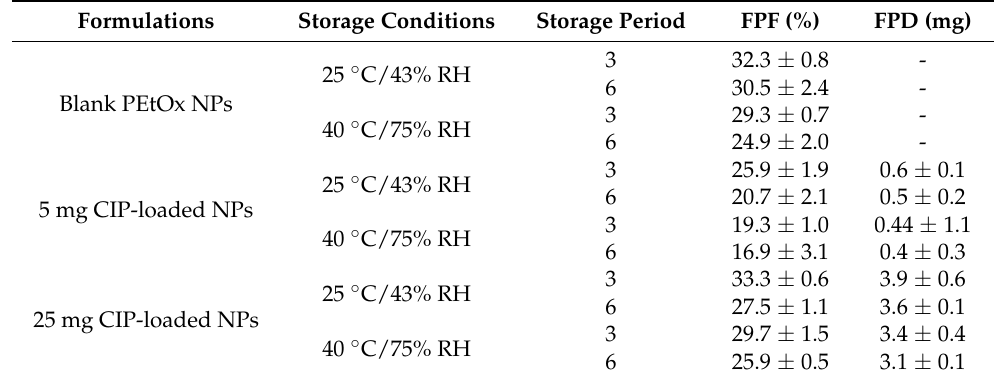
Table 2. Aerosol performance of blank and CIP-loaded PEtOx NPs after 3 months and 6 months of storage at 25 ◦ C/43% RH and 40 ◦ C/75% RH.